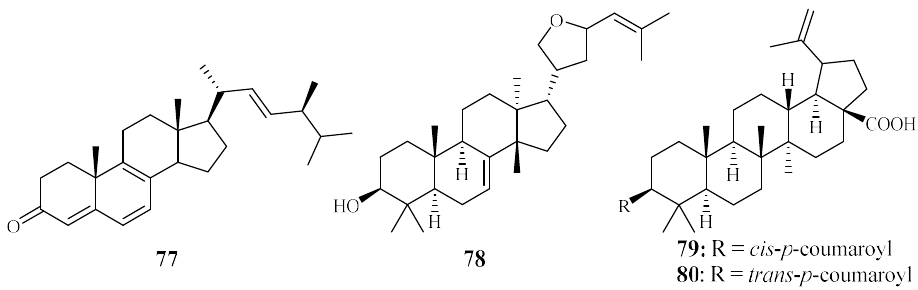
Figure 13. Compounds from a Cornaceae plant.